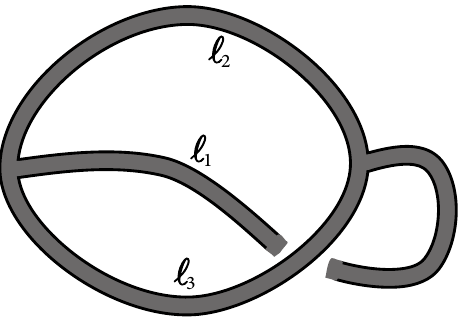
Figure 2 . The torus with one puncture V 1 , 1 ( b ) becomes a ribbon graph, when the hole b becomes large. In this limit the moduli space is spanned by the lengths of the ribbons with the constraint b = 2 ‘ 1 + 2 ‘ 2 + 2 ‘ 3 , and we integrate with the flat measure to recover V 1 , 1 ( b ) = b 2 / 48 . The right hand side is in integral over the moduli space of Riemann surfaces. Just like